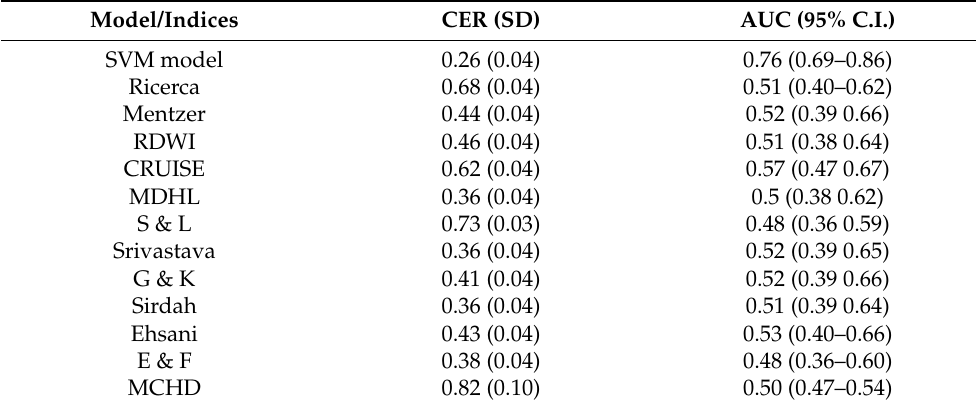
Table 3. The performance comparison for test datasets based on 1000 replications.